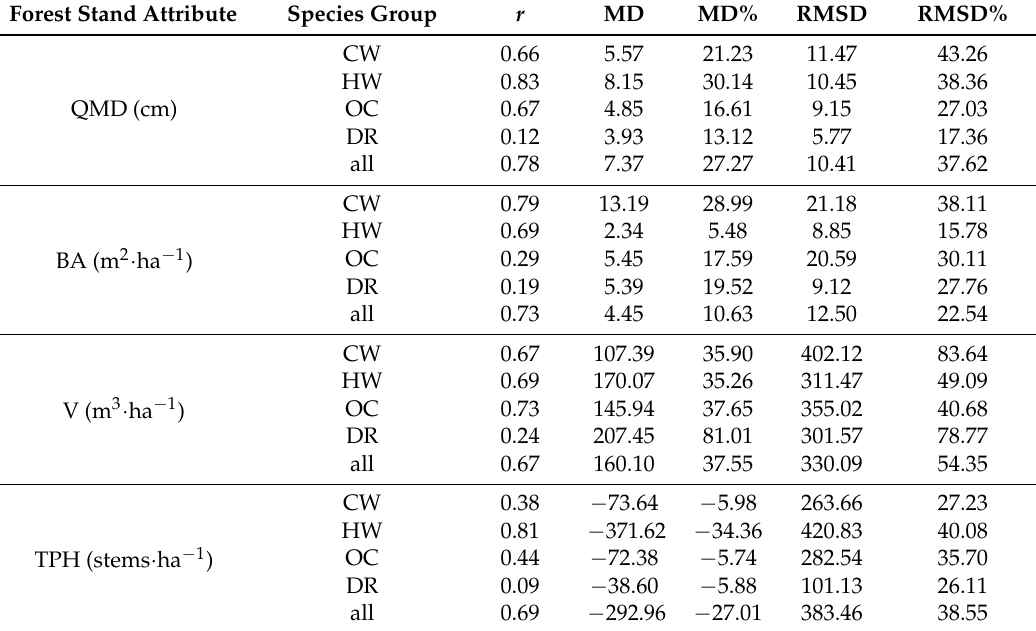
r —Pearson correlation coefficient.